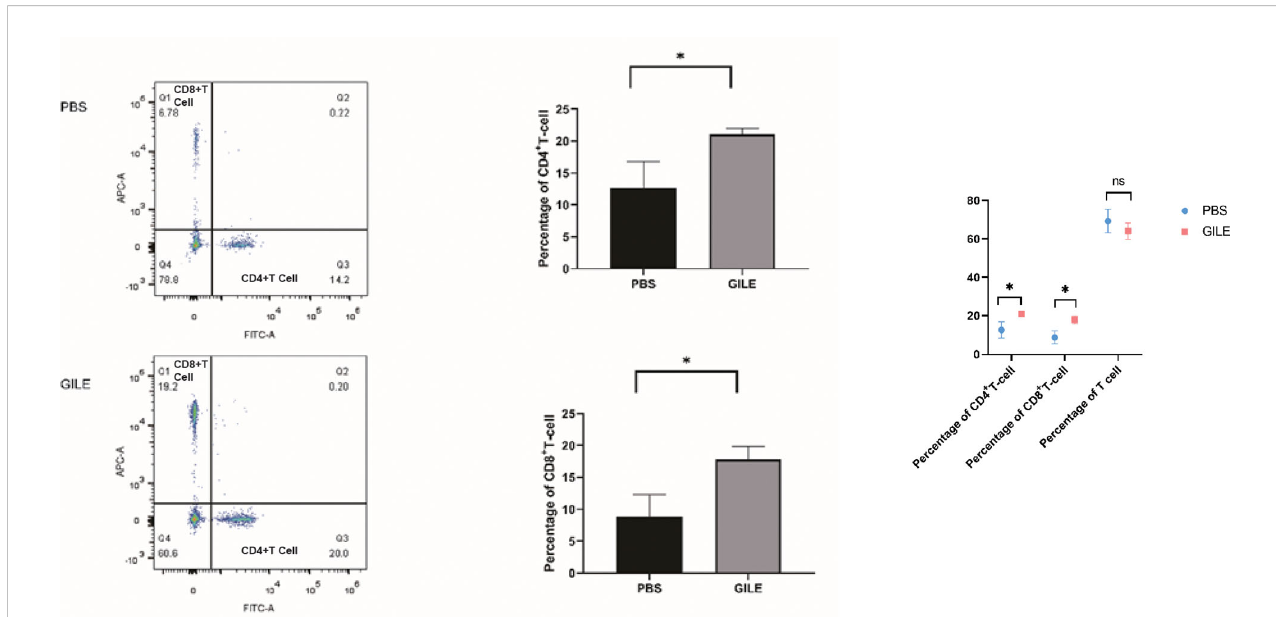
FIGURE 8 Detection of every groups ’ mice spleen CD4 + T cell and CD8 + T-Cell level by FCM; The CD4 + T cells were labeled with Anti-Mouse CD4 FITC (Abcam) and CD8 + T cells were labeled with Anti-Mouse CD8a APC(Abcam), CD4 + , CD8 + T cells population level were detected by fl ow cytometry, Q1 showed the CD8 + cell population, Q3 showed the CD4 + cell population, Q4 showed the total lymphocyte population (*:P<0.05). ns means no statistical signi fi